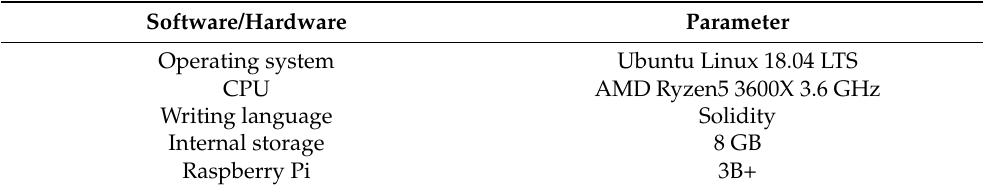
Table 3. Experimental environment.